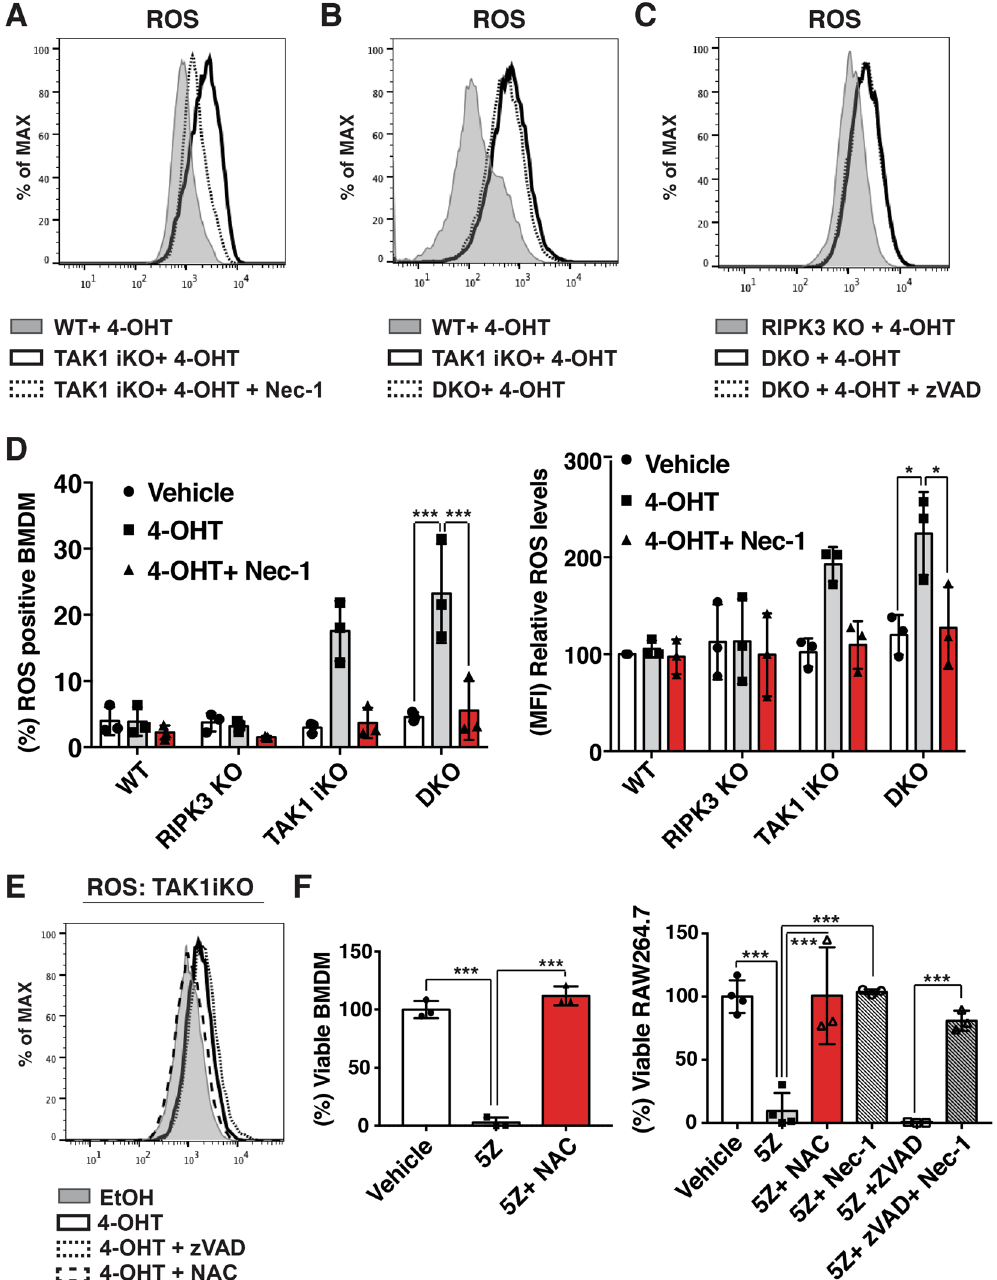
Figure 3. RIPK1 activity drives oxidative stress-induced cell death in Tak1 -deficient macrophages through a caspase- and RIPK3- independent death pathway ( A ) WT and TAK1 iKO BMDMs were treated with 0.3 µ M 4-OHT + / − 50 µ M Nec-1 for 4 days, stained with CM-H 2 DCFDA and analyzed by flow cytometry. Cells were gated to exclude debris. The result shown is representative of three independent experiments ( B ) WT, TAK1 iKO and RIPK3 KO BMDMs were treated with 0.3 µ M 4-OHT for 4 days. The result shown is representative of three independent experiments ( C ) RIPK3 KO and DKO were treated with 0.3 µ M 4-OHT + / − 20 µ M zVAD for 4 days. The result shown is representative of three independent experiments ( D ) WT, RIPK3 KO, TAK1 iKO , and DKO BMDMs were treated with 0.3 μ M 4-OHT or vehicle (ethanol) + / − 50 µ M Nec-1. ROS positive BMDM and the relative ROS levels are shown. Data are the result of 3 independent experiments and show mean percentages + / − SD. * p-value < 0.05; *** p-value < 0.001; two-way ANOVA. ( E ) TAK1 iKO BMDMs were treated with 0.3 µ M 4-OHT with or without 7.5 mM NAC or 20 µ M zVAD for 4 days. Cells were gated to exclude debris. The result shown is representative of three independent experiments. ( F ) RAW264.7 and WT BMDMs were incubated with 200 nM 5Z-7-oxozeaenol (5Z) with or without 7.5 mM NAC, 20 µ M zVAD and 50 µ M Nec-1 for 24 h. Cell viability was measured by crystal violet assay. Data are the result of 3 independent experiments and show mean percentages + / − SD. *** p-value < 0.001; one-way